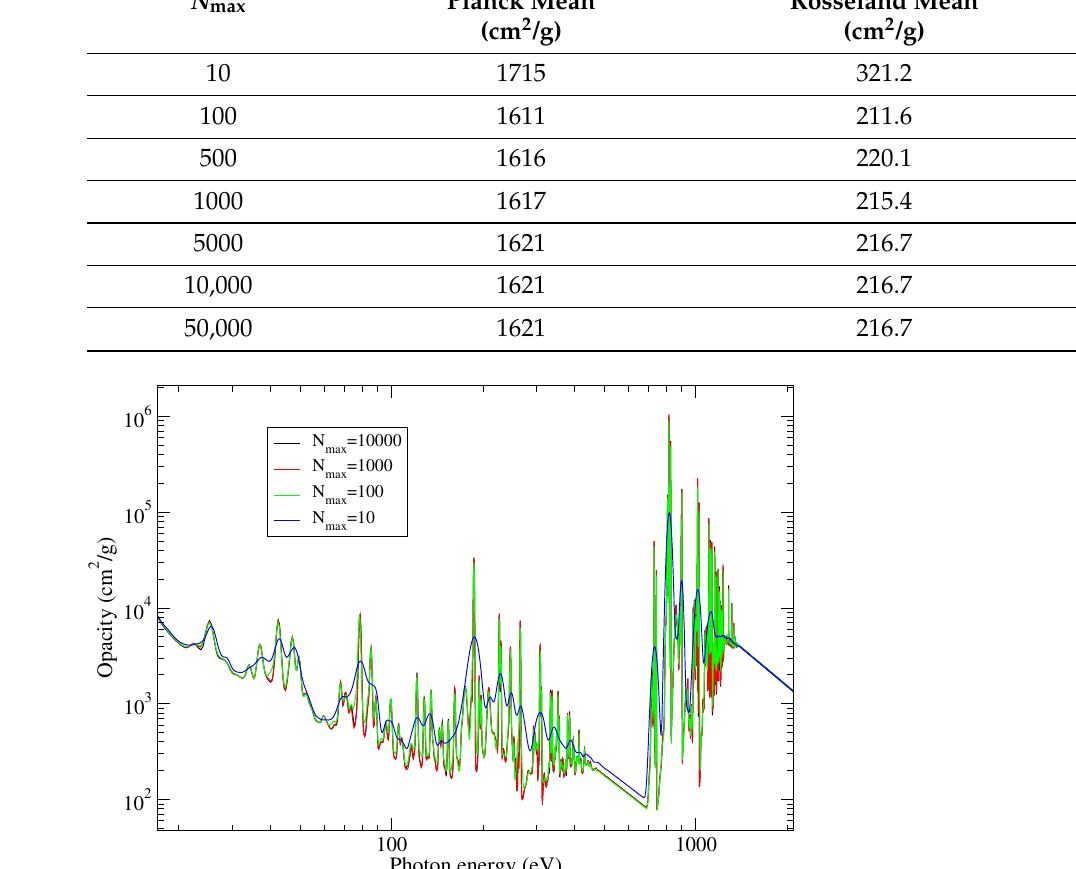
Figure 1. Total opacity of an iron plasma at T = 100 eV and ρ = 10 − 3 g/cm 3 computed in the different cases N max = 10, 100, 1000 and 10,000, which characteristics are provided in Table 1. The black ( N max = 10,000) and red ( N max = 1000) curves are almost